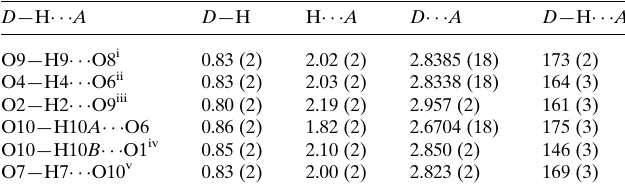
Table 2 Experimental details.